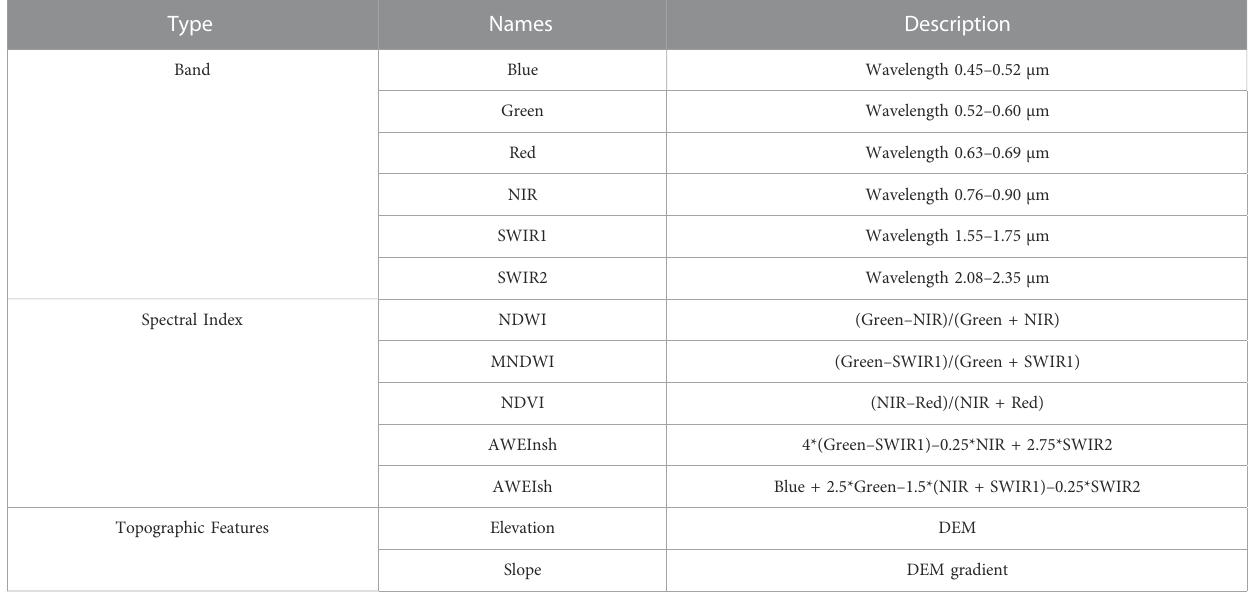
TABLE 2 Features list of water classi fi